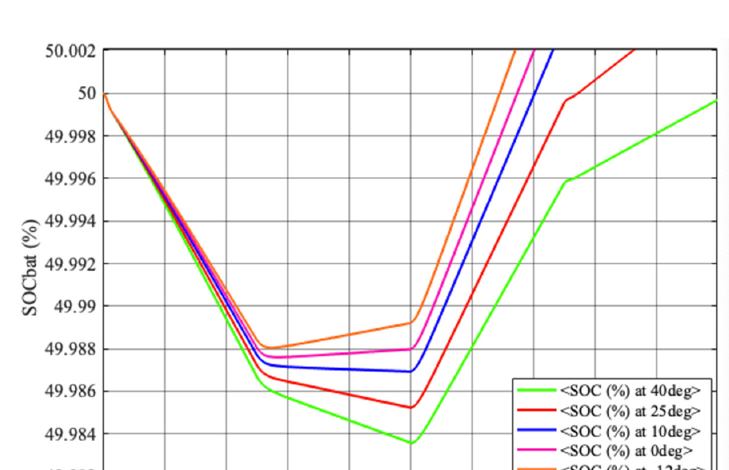
Figure 13. 𝑆𝑂𝐶 (cid:3029)(cid:3028)(cid:3047) in the PV-HESS system using the TI controller for different temperatures. Figure 12. 𝑆𝑂𝐶 (cid:3029)(cid:3028)(cid:3047) in the PV system with a supercapacitor for the PI, FOPI, and TI controllers. Table 5. Consumption of 𝑆𝑂𝐶 (cid:3029)(cid:3028)(cid:3047) for the PI, FOPI, and TI controllers.